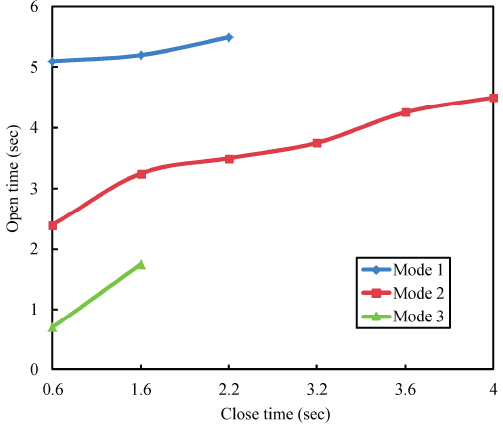
Figure 14. Opening and closing times and situational mode simulation